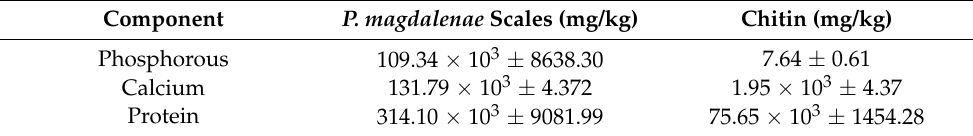
Table 1. Quantification of components other than chitin in P. magdalenae scales.